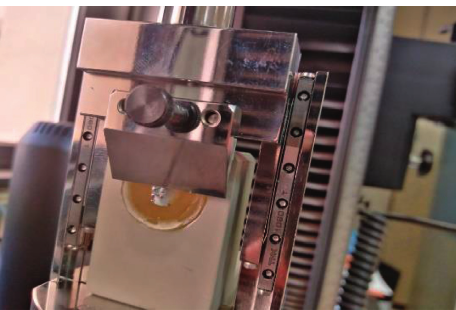
Figure 4: Force applied by the universal testing machine tapered blade between the bracket base and the